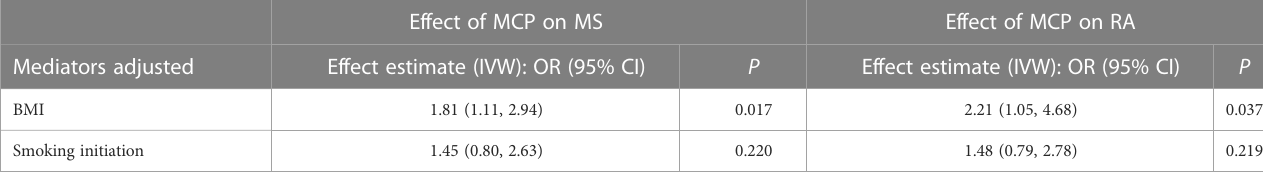
TABLE 4 Causal effect of multisite chronic pain on MS/RA in multivariable Mendelian randomization analyses. Effect of MCP on